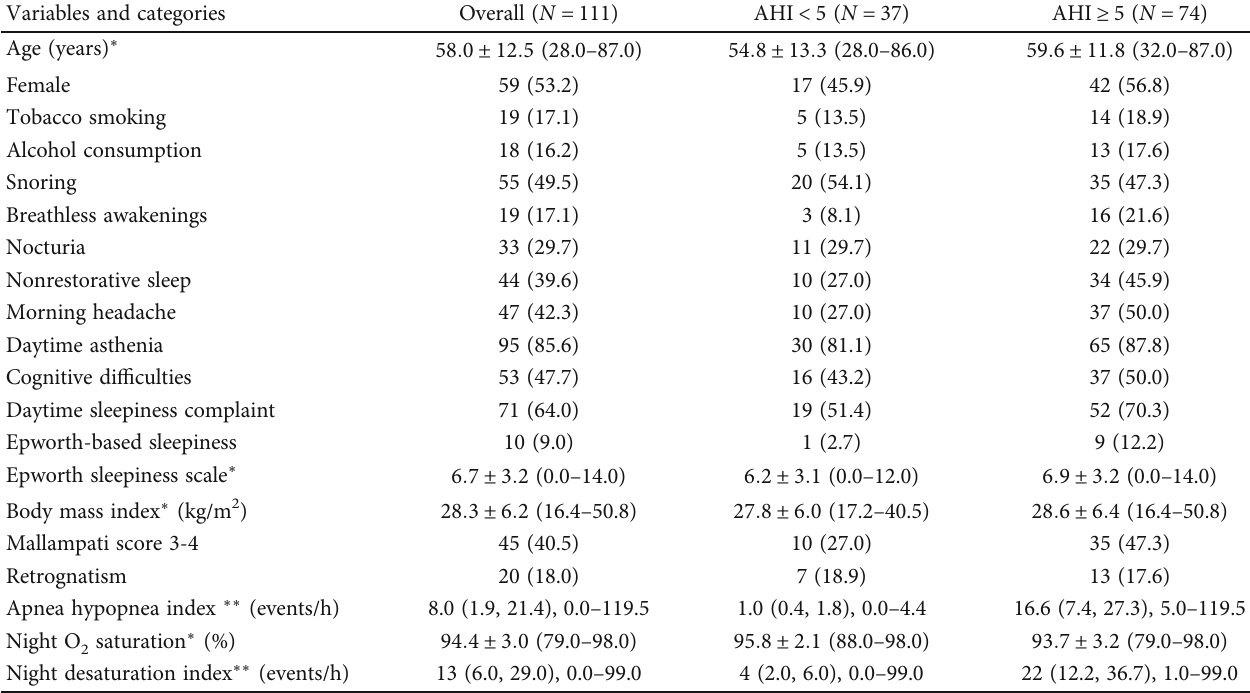
Table 1: Sociodemographic, clinical, and sleep monitoring characteristics of patients hospitalized in Yaoundé Central Hospital, according to AHI category, November 2016 – May 2017, Yaoundé, Cameroon.